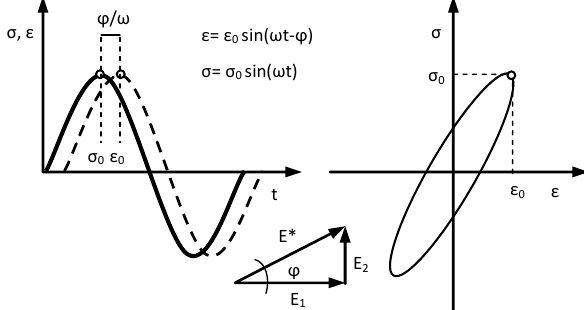
Figure 3. Fatigue hysteresis used for the identification of parameters. ϕ : phase angle (°); ω : angular frequency = 2 π f (1 / s); t : time (s); σ 0 : the amplitude of stress (MPa); ε 0 : the amplitude of deformation (-); E *: composite modulus (MPa); E 1 : the real element of the composite modulus (MPa); E 2 : the imaginary element of composite modulus (MPa).